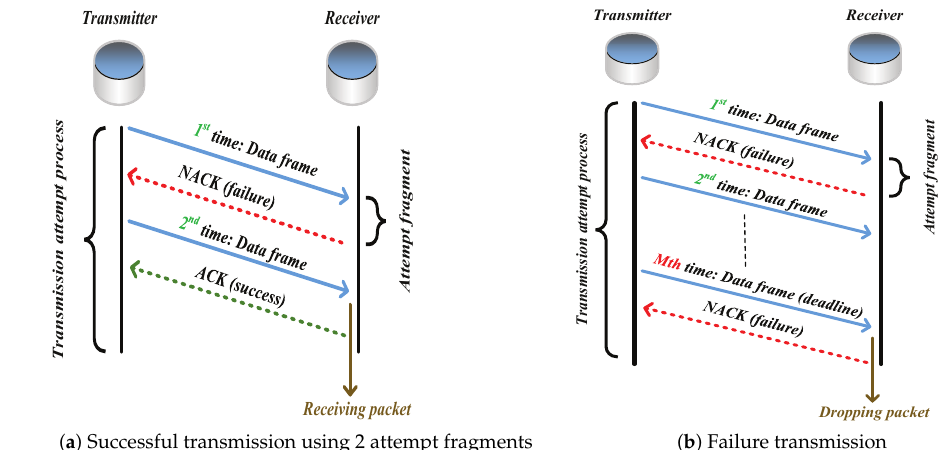
Figure 1. Transmission attempt process using ARQ